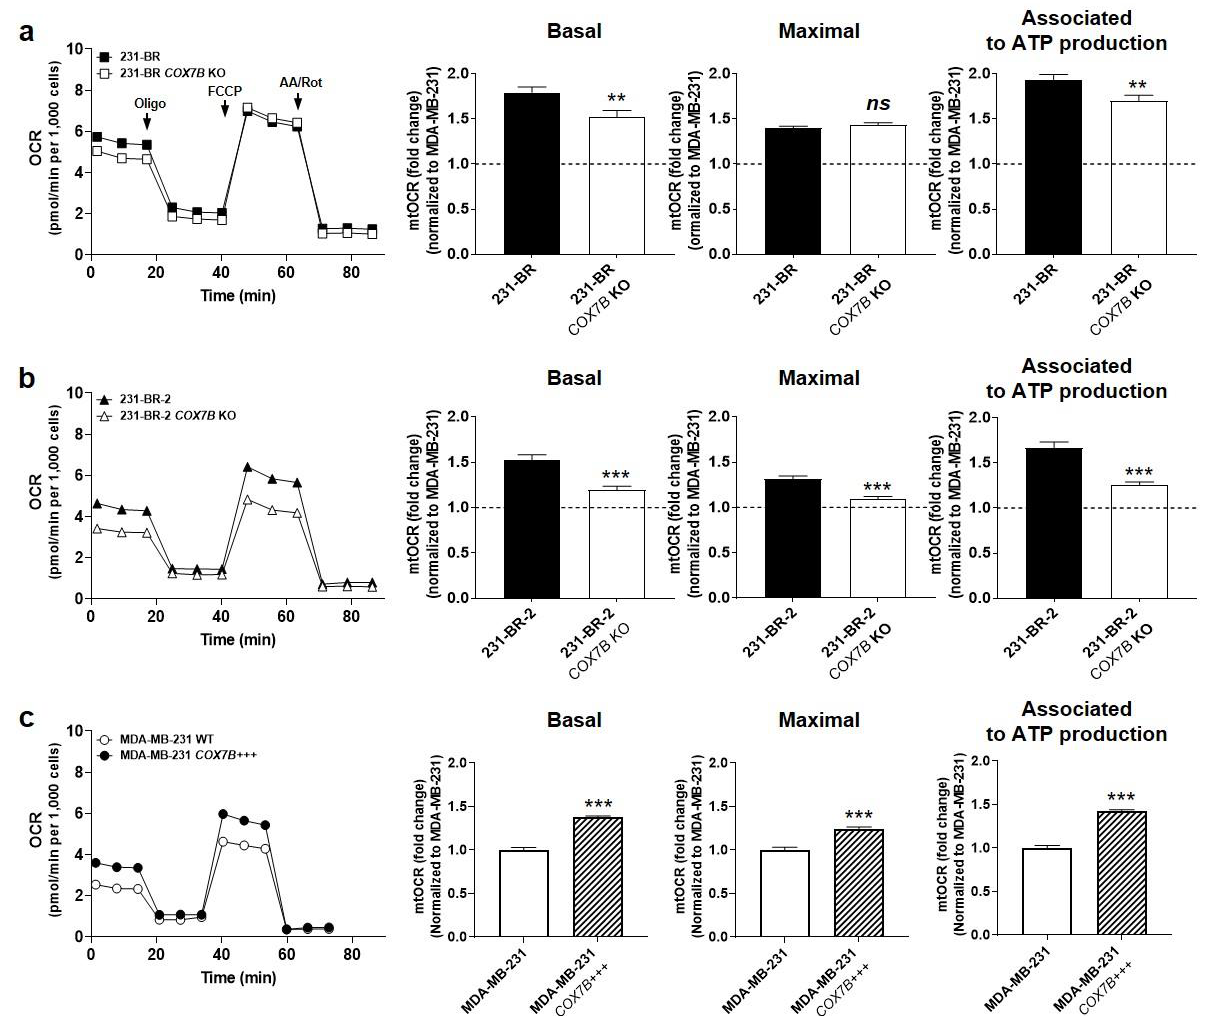
Figure 5. Cox7b expression drives the oxidative switch of brain-seeking variants. ( a ) 231-BR brain-seeking variants expressing or not expressing (KO using a CRISP-Cas9 strategy) Cox7b. Basal ( left ) and maximal ( middle ) oxygen consumption rates (mtOCRs), as well as the OCR of the cells associated to mitochondrial ATP production ( right ), were measured using a XF Cell Mito Stress Test Kit (Agilent) on a Seahorse XF96 bioenergetics analyzer ( n = 20 all). Representative Seahorse traces are shown on far left. ( b ) As in ( a ), but using 231-BR-2 brain-seeking variants expressing or not expressing Cox7b ( n = 15 – 20). ( c ) As in ( a ), but using MDA-MD-231 parental cancer cells overexpressing or expressing basal levels of Cox7b ( n = 23 – 32). All data are normalized to control (dotted lines) and are shown as means ± SEM. ** p < 0.01, *** p < 0.005, ns: p > 0.05; using Student’s t -test ( a – c ).